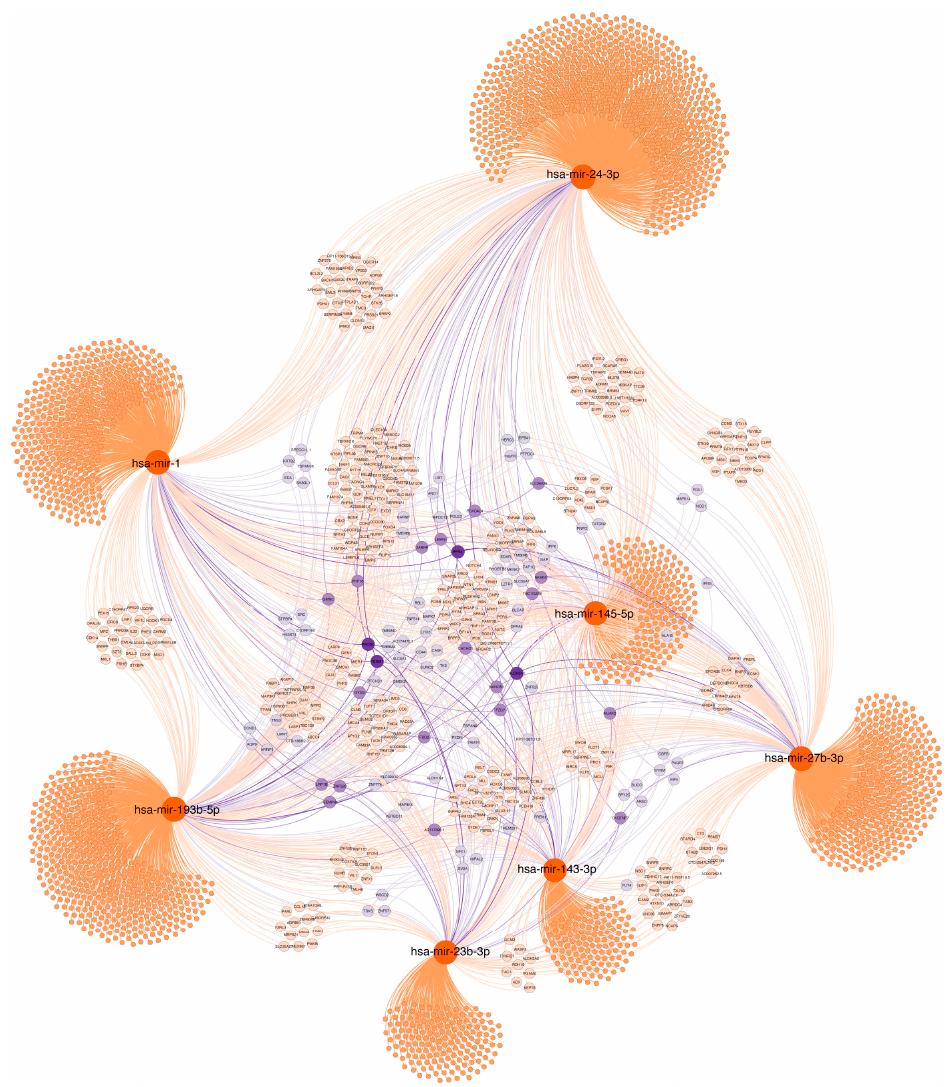
Figure 6. Target gene networks of validated miRNAs associated with age and Lynch syndrome. Selected miRNAs are highlighted in orange. Genes with at least two potential interactions were labelled. Genes with just one connection are unlabelled. Colour nodes of regulated genes are proportional to node degree (number of connections).